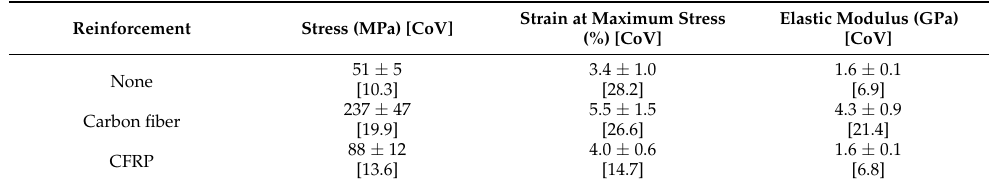
Table 9. Comparison between epoxy resin, composites manufactured with carbon fiber as reinforce- ment and composites manufactured with a mechanically recycled CFRP as reinforcement.